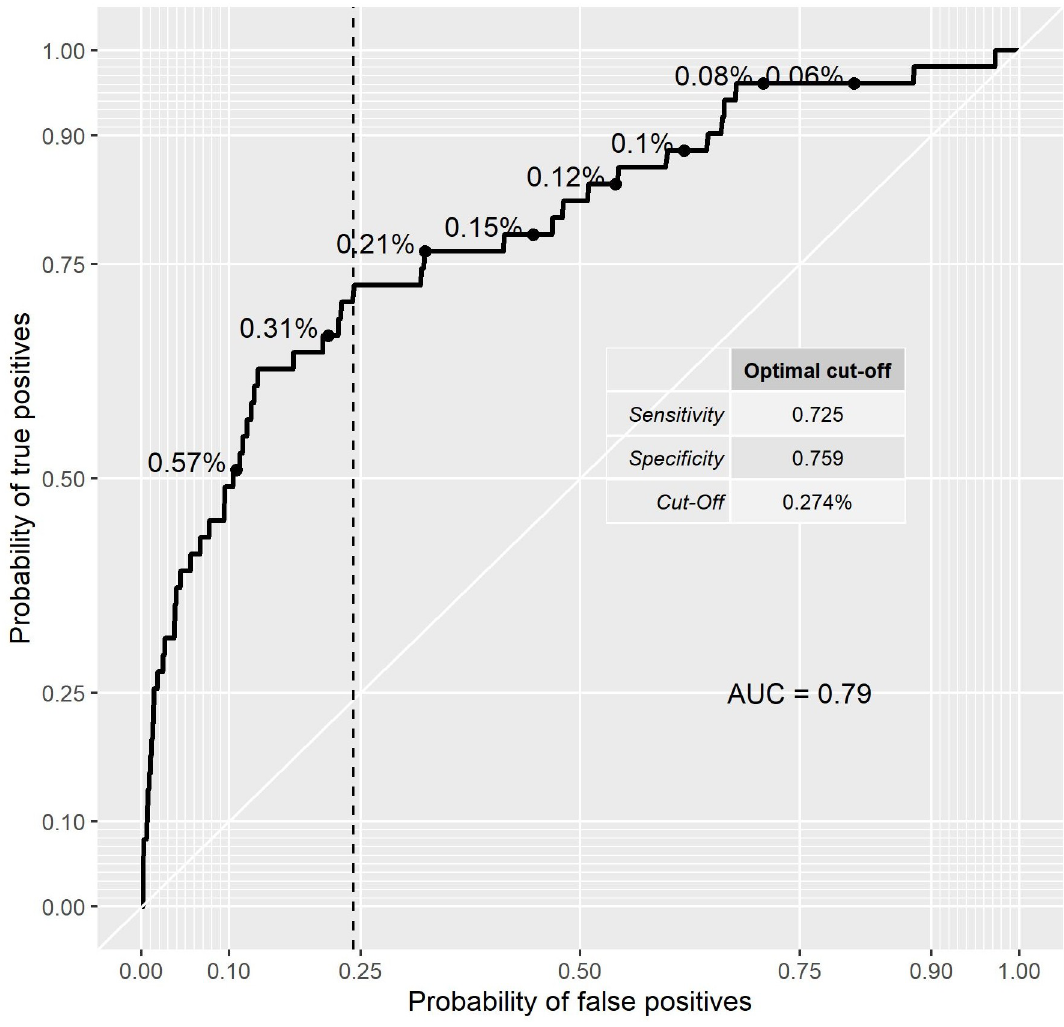
Fig 9. Sensitivity and specificity of prediction model on test data